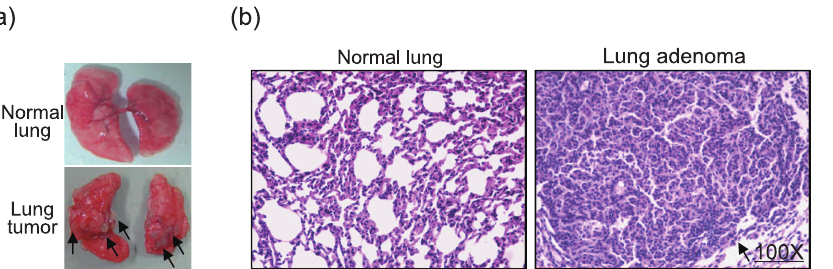
Figure 2. Examination of lung tumors on A/J mice. Tumor pathology of lung tumors in A/J mice treated with NNK for 24 weeks. (a) Images of the lung surface indicate that NNK-treated mice lungs presented with numerous visible lesions (black circles) and (b) the histological characteristics of mouse lungs stained with H&E from control and NNK treatment groups. Arrows indicate the adenocarcinoma in the lungs (magnification, 6 100).